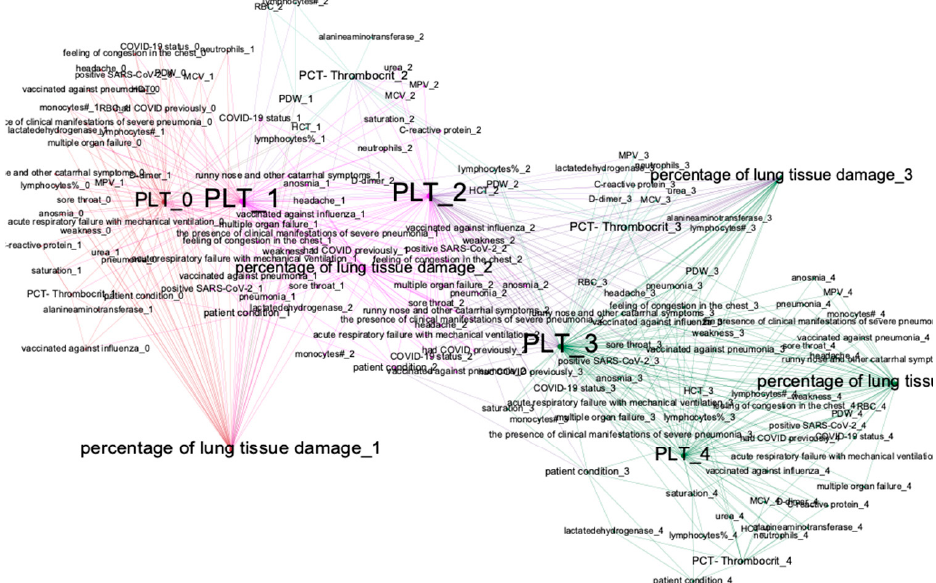
Figure 9. DBN for predicting time series of patient condition indicators.